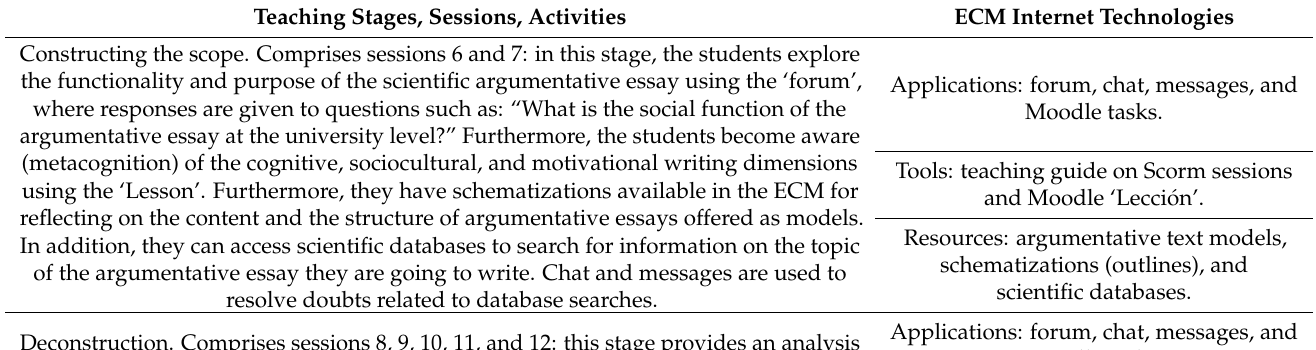
Table 4. Phase 2 of the